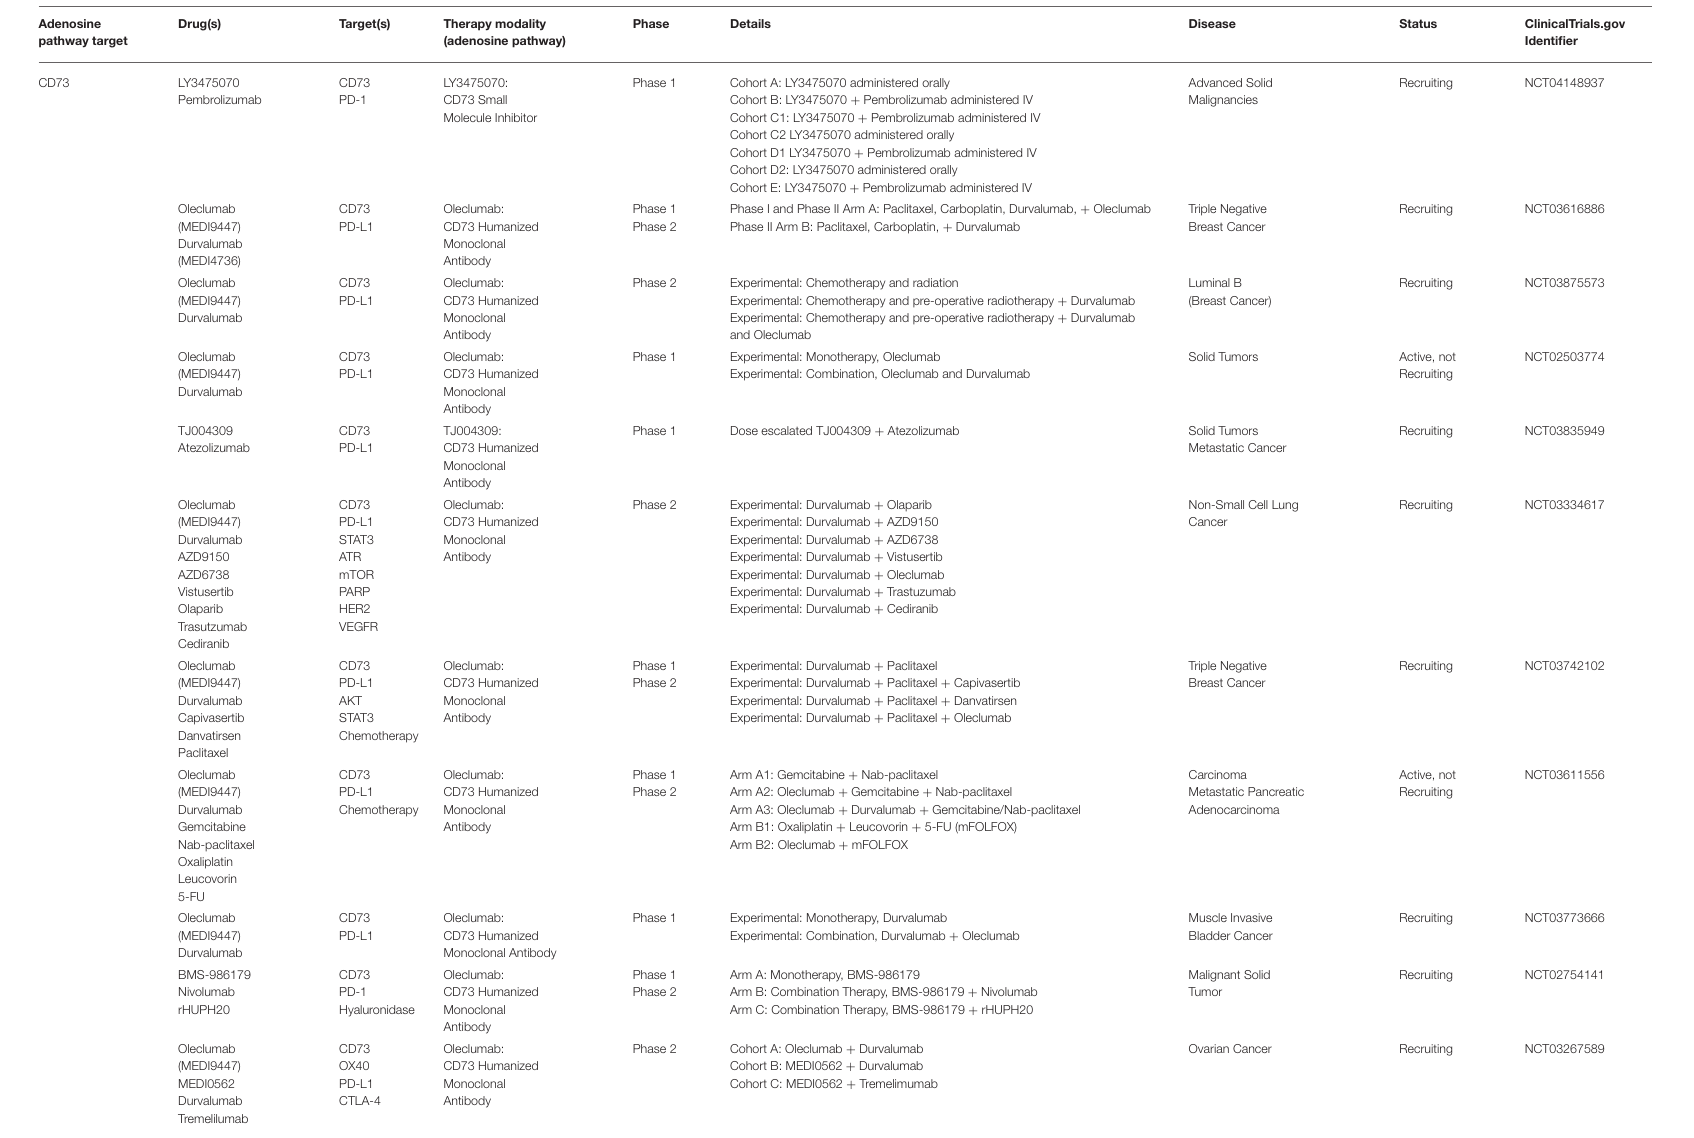
TABLE 3 | Summary of clinical trials for CD73, A2AR, and A2BR in cancer. Adenosine